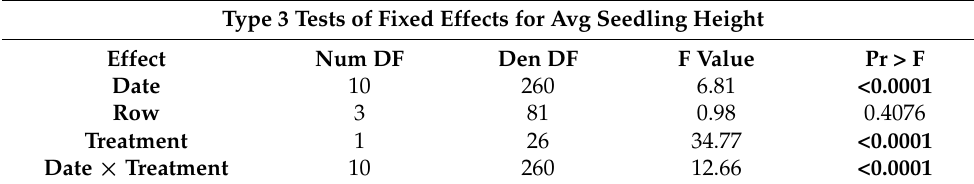
Table 1. Results of mixed model analysis for average seedling height.